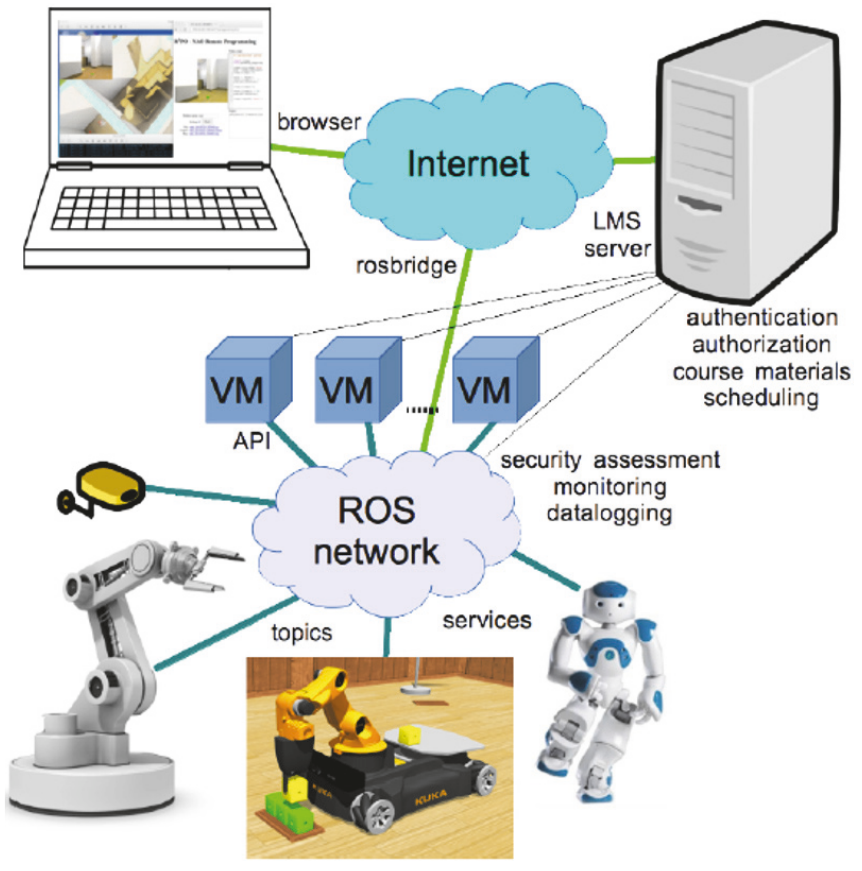
Figure 1: Overall architecture of the Robot Programming Network: the user is connected to Internet via a browser and is granted access to the LMS server. The user’s code is run on a Virtual Machine, where it uses a secure API for interacting with the ROS modules of the network, through the available ROS topics and